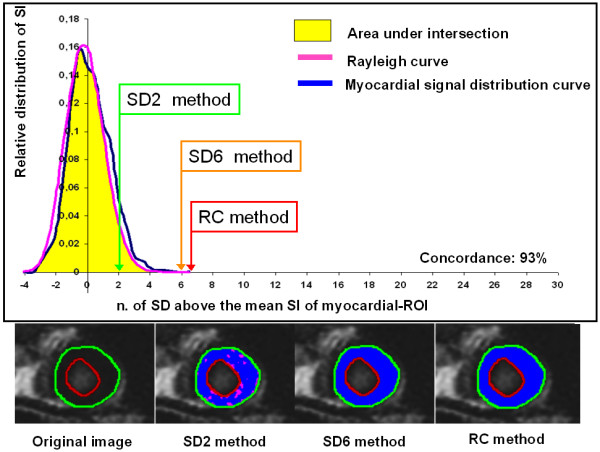
Comparison between the methods in a control. Analysis of an original LGE image of a control patient. The upper panel shows the relative distribution of pixel intensity of myocardium (blue line) and the Rayleigh curve derived from the signal of the background-ROI (pink line). In this patient there is a good overlap between the two curves (concordance 93%). The thresholds of SD2, SD6 and RC methods are evidenced. In the inferior panels in left to right order are showed the original LGE image contoured, the parametric map derived from the SD2 method, from the SD6 method and from the RC method. In this case SD2 committed a large overestimation of enhancement as evidenced both in the graph and in the parametric map.